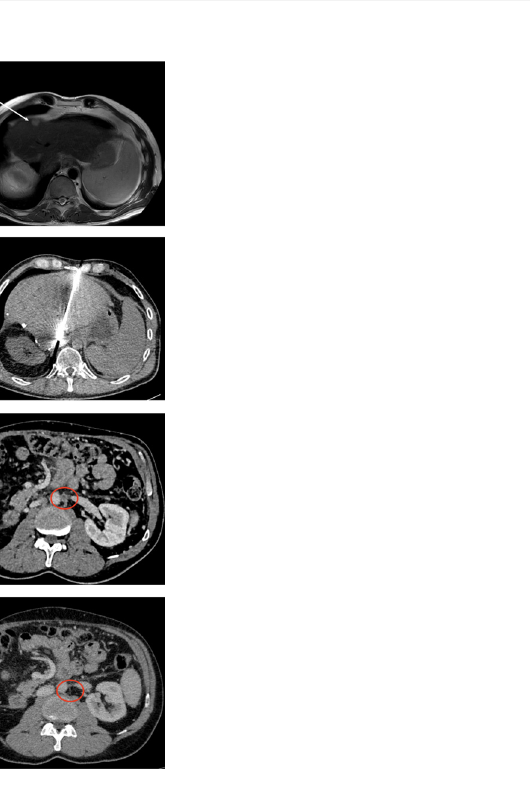
FIGURE 1 Representative CT and MRI scans showing different disease stages and local ablative therapy during the disease course. (A) MRI (T2) of July 2017. White arrow points toward intrahepatic cholangiocarcinoma in segment V/VIII at fi rst presentation. (B) MRI (T2) of October 2018 revealing a singular hepatic metastasis (white arrow). (C) Second intrahepatic recurrence of CCA (white arrow) diagnosed by MRI (T2) in February 2020. (D) CT-guided microwave ablation of this second hepatic metastasis in February 2020. (E) CT (portal venous phase) showing central necrotic lymph node metastases (red circles) in October 2020, before initiating olaparib/pembrolizumab combination therapy. (F) In July 2021, CT scan (portal venous phase) shows partial and complete remission of lymph node metastases after about 9 months of treatment with olaparib and